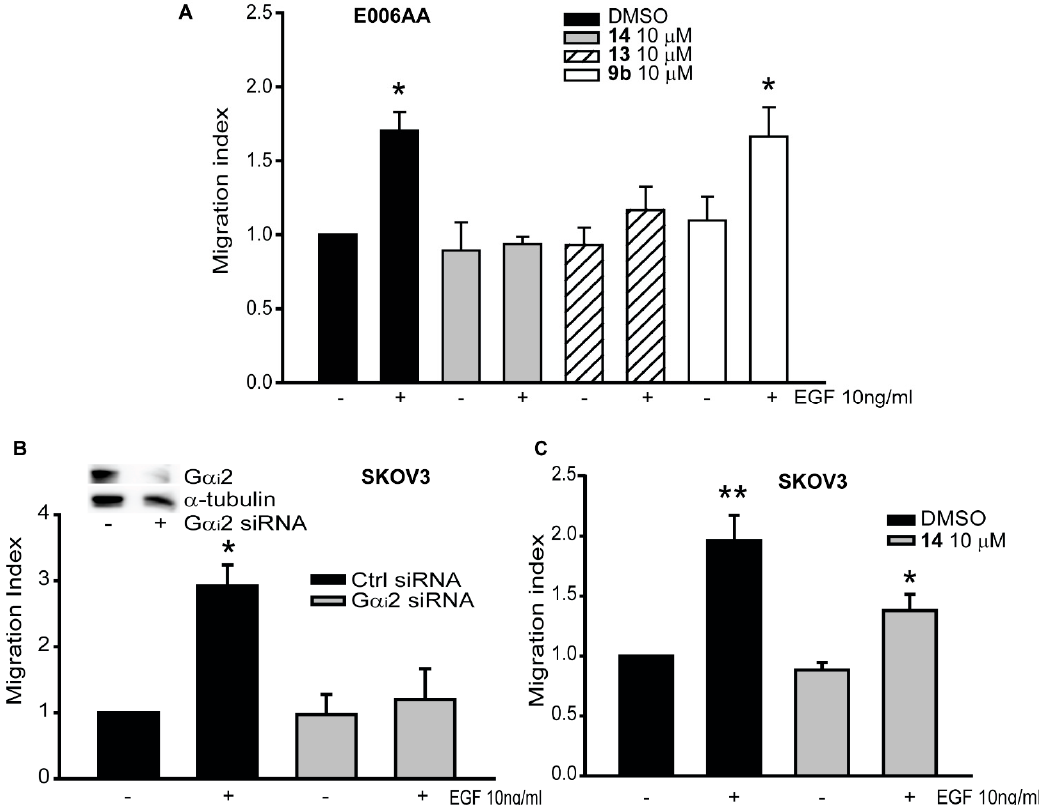
Figure 5. Inhibition of G α i 2 decreased migratory capability of renal, breast and ovarian cancer cells. ( A ) E006AA cells were subjected to transwell migration assay, incubated with or without the three inhibitors ( 9b , 13 and 14 ) at the final concentration of 10 µ M, in the presence ( + ) or absence ( − ) of EGF (10 ng / mL). The results are expressed as migration index. Each bar represents mean ± SEM. ( B ) SKOV3 cells were transfected with control and G α i 2 siRNAs and then subjected to transwell migration assays in the presence ( + ) or absence ( − ) of EGF (10 ng / mL). Results are expressed as migration index. Each bar represents mean ± SEM. ( C ) SKOV3 cells were incubated with or without compound 14 at 10 µ M, and then subjected to transwell migration assay in the presence ( + ) or absence ( − ) of EGF (10 ng / mL). The results are expressed as migration index. Each bar represents mean ± SEM (* p ≤ 0.05; ** p ≤